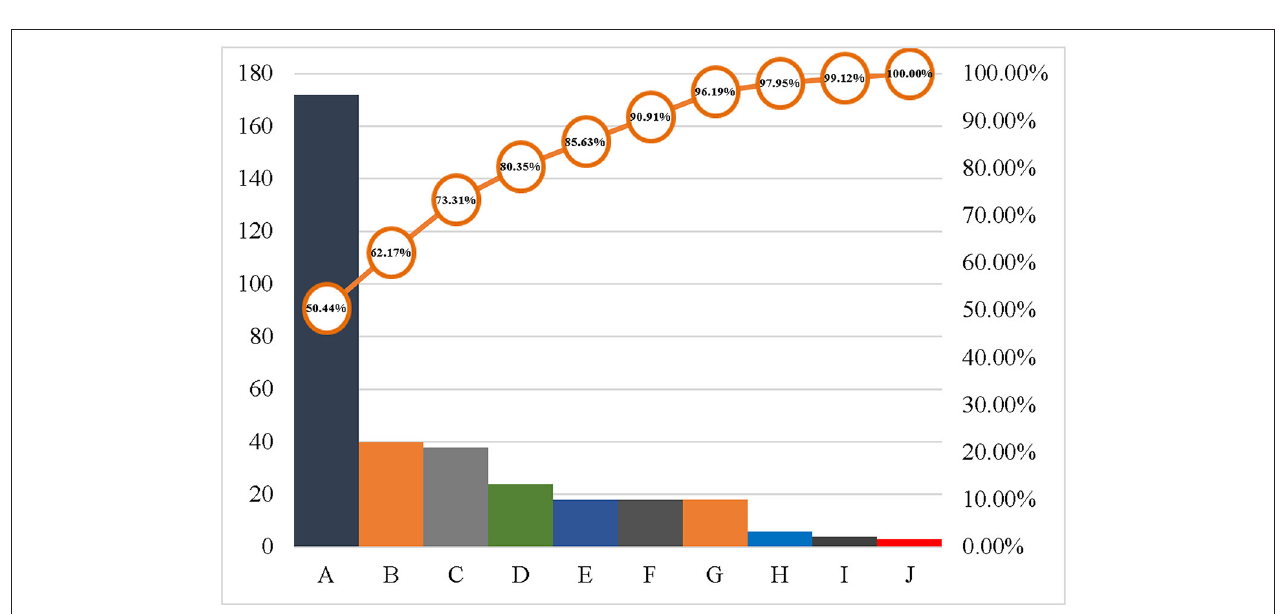
FIGURE 1 | The frequency of serious workplace violence (WPV) between 2011 and 2020.